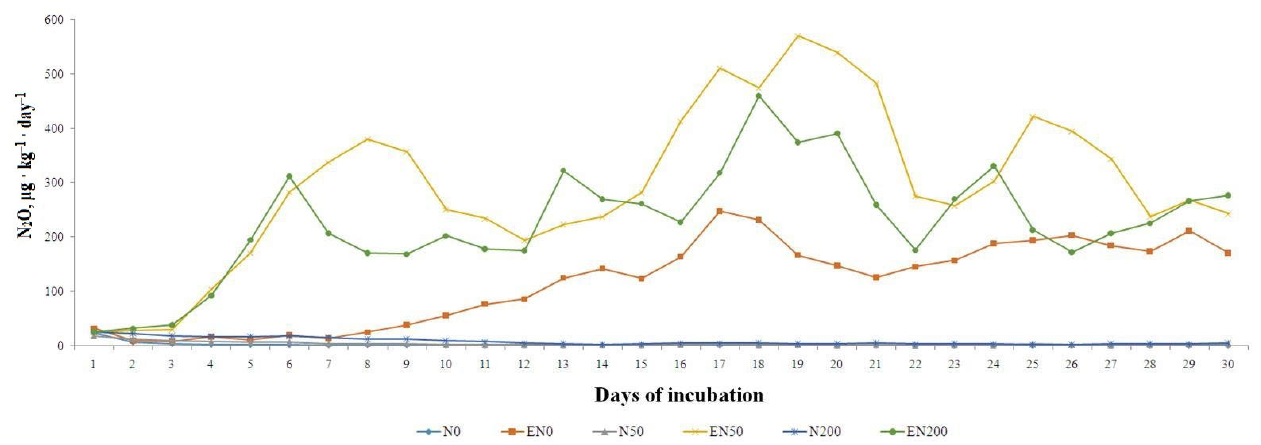
Figure 3. Daily dynamics of N 2 O emission ( μ g kg − 1 day − 1 ).